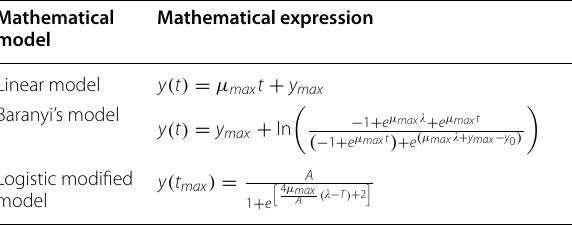
Table 2 Selected mathematical model for characterizing kinetic